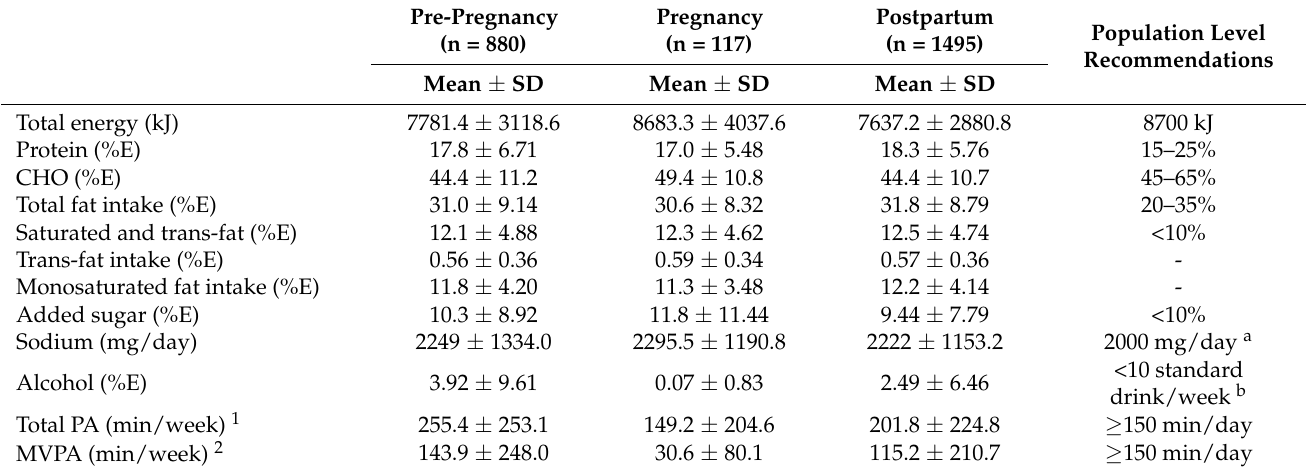
Table 3. Energy and macronutrient intake and PA in women across reproductive life